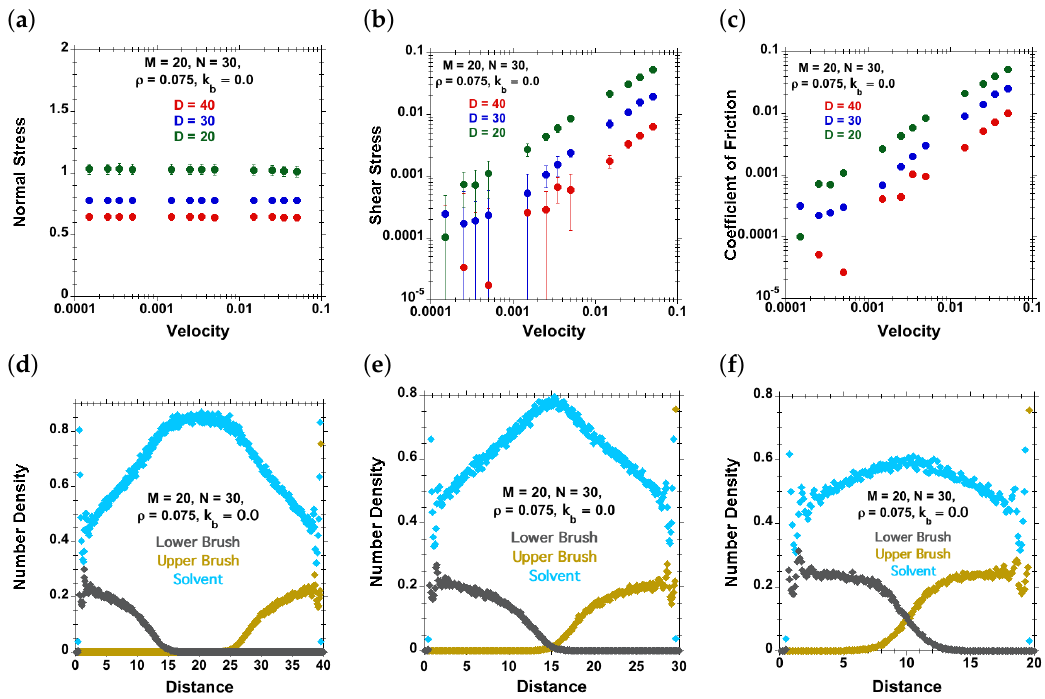
Figure 6. Effect of separation distance D (red dots for D = 40, blue dots for D = 30 and green dots for D = 20) for symmetric brushes under good-solvent conditions, carrying M = 20 chains on each tethering surface. Each linear, flexible ( k b = 0) chain has N = 30 beads, and the grafting density is ρ = 0.075. ( a ) Normal stress against velocity; ( b ) shear stress against velocity; ( c ) coefficient of friction against velocity. Density profiles at shear velocity, v = 0 of solvent (cyan dots), lower polymer-chains (grey dots) and upper polymer-chains (brown dots) at ( d ) D = 40, ( e ) D = 30 and ( f ) D =